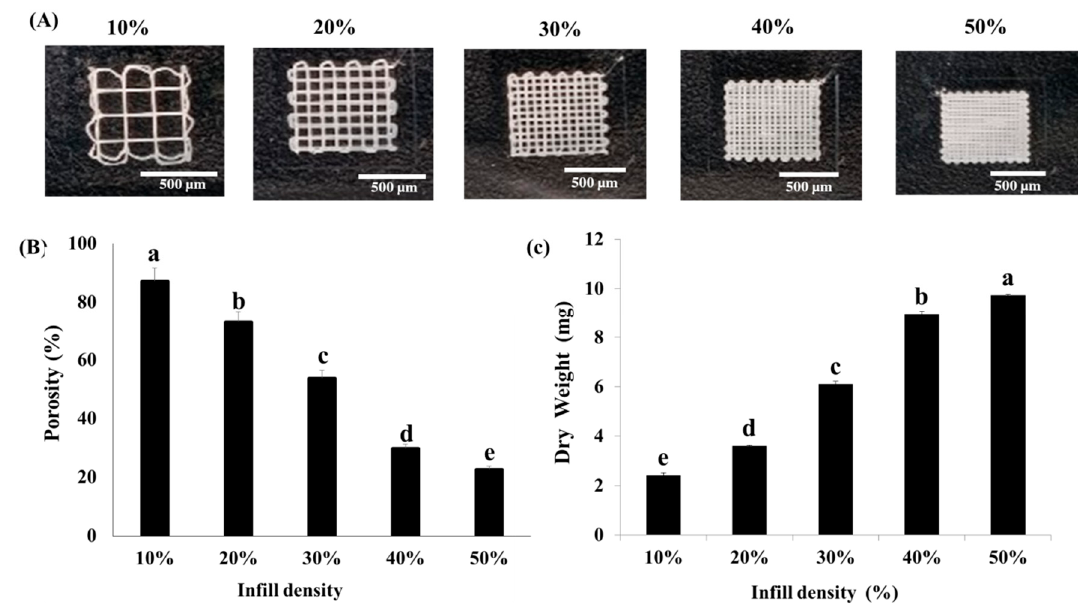
Figure 2. Characteristics of three-dimensional printed industrial acrylonitrile butadiene styrene scaffolds with different infill densities (10%–50%). ( A ) Photographs of industrial ABS scaffolds with infill densities ranging from 10% to 50%. Scale bar: 500 µm. ( B ) Measured porosity. ( C ) Measured dry weight. Results are expressed as mean ± SD. Significant differences ( p < 0.05) are represented using different letters.